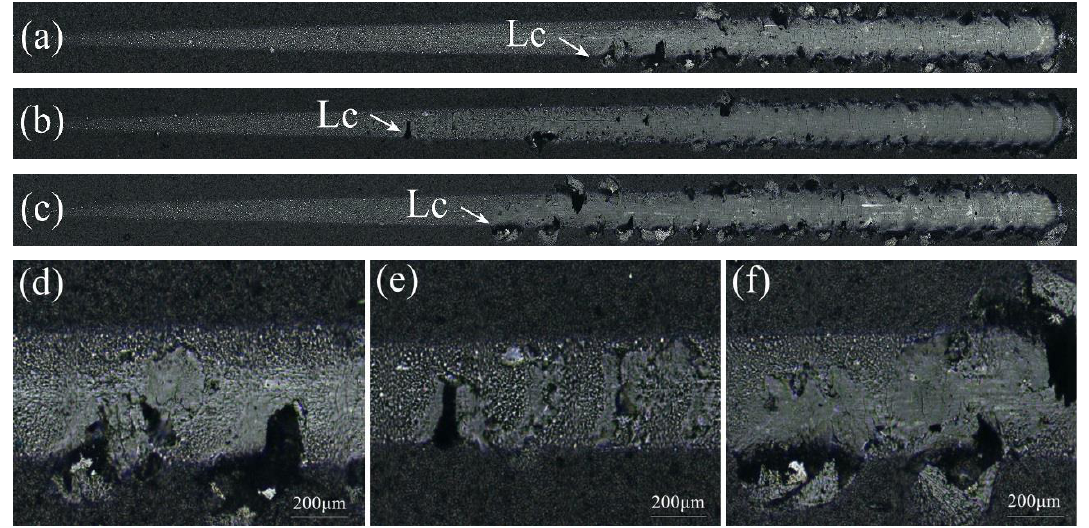
Figure 7. Images of scratch scar and partial enlargement of the three coatings after scratch tests, ( a , d ) AlCrSiN coating, ( b , e ) AlCrSiON coating, ( c , f ) AlCrSiN/AlCrSiON duplex coating.